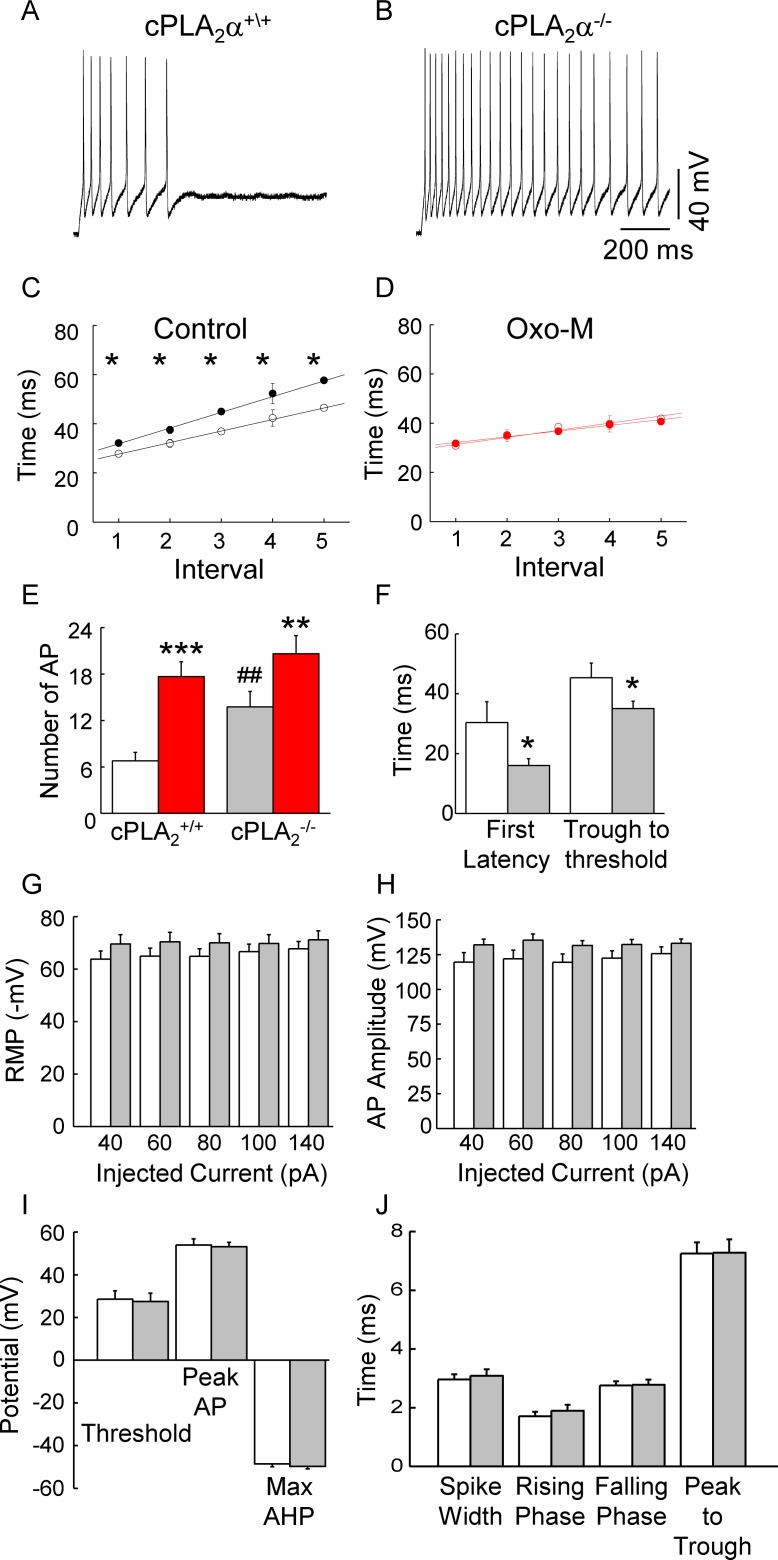
Decreases in time from AHP to threshold account for increased firing of cPLA2α-/- SCG neurons.(A-B) Examples of differences in AP firing during a 1 sec injection of 100 pA of current. (C) IPI is significantly shorter in cPLA2α-/- (solid circles) compared to cPLA2α+/+ (open circles) cells at all intervals (*p ≤ 0.05; n = 17–23 cells/data point). (D) Following exposure to Oxo-M, IPI interval lengths of cPLA2α-/- (solid circles) and cPLA2α+/+ (open circles) cells superimpose (n = 8–18 cells/data point). (E) cPLA2α-/- neurons (n = 22) compared to cPLA2α+/+ neurons (n = 34) exhibit increased basal (open bars) frequency of firing (##p ≤ 0.00015), but no difference in frequencies (p = 0.377) following Oxo-M (red bars). Both cPLA2α+/+ (***p ≤ 6 x 10−5; n = 18) and cPLA2α-/- (**p ≤ 0.005; n = 8) neurons exhibit increases in firing frequency following Oxo-M. (E-J) Open bars, cPLA2α+/+ neurons; grey bars, cPLA2α-/- neurons, red bars, 10 μM Oxo-M. All analyses were performed on APs elicited with 100 pA unless otherwise specified. Properties of APs were measured from the 3rd AP of a train from 3 sequential traces and averaged for each recording. (F) Decreased latency to first firing (*p ≤ 0.05) and time from the trough of the AHP to threshold (*p ≤ 0.05) underlie the changes in IPI (n = 25–33 cells/group). (G) Resting potential and (H) AP amplitude of cPLA2α+/+ (open bars) vs cPLA2α-/- (grey bars) SCG neurons were not significantly different (p > 0.05; n = 15–18) across a range of current injections. (I) Summary of average voltage change from AHP to threshold during an 80 pA current injection (n = 17 cells/group), peak AP (n = 26–27 cells/group), and maximal after hyperpolarization (n = 26–27 cells/group). See S2 Fig for a schematic and further details of measurements. (J) Summary of the AP duration. Spike Width, measured at ½ the AP amplitude; Rising Phase, measured at 1/3 the AP potential to the peak AP; Falling Phase, measured from the peak AP to 1/3 the AP potential; Peak to Trough, measured from the peak AP to the AHP (n = 26–27 cells/group).